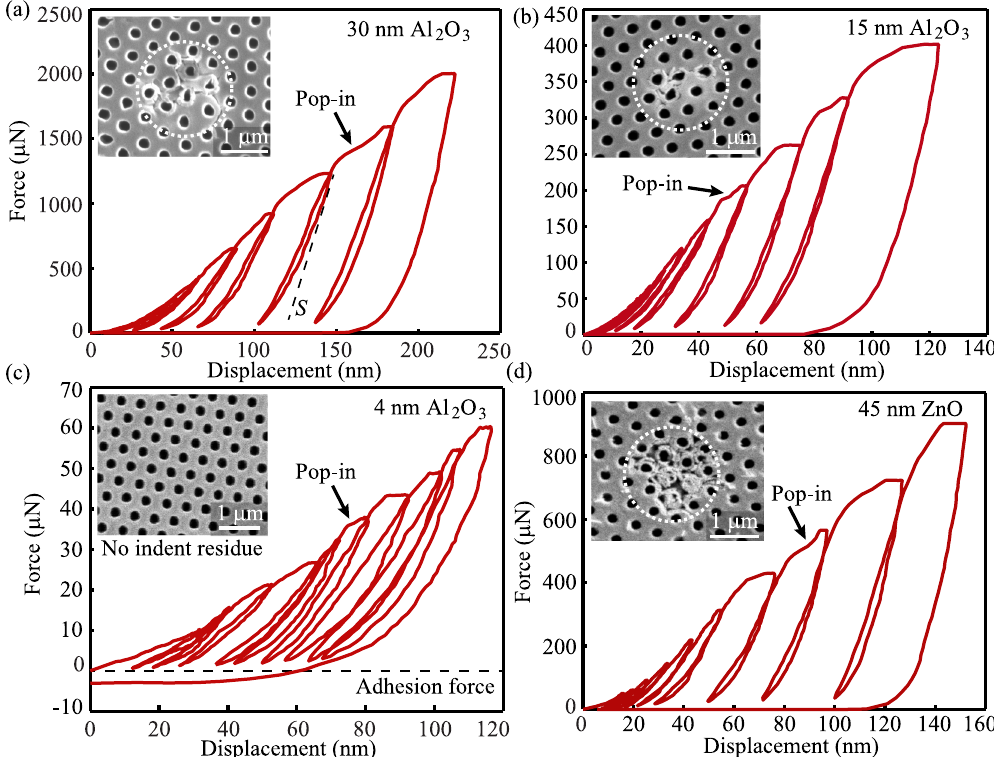
Figure 2. Mechanical testing of nanolattice using nanoindentation. ( a ) Typical cyclic load-displacement curve for 30 nm Al 2 O 3 nanolattice. ‘Pop-in’ indicates first instance of mechanical failure of nanolattice film. Inset shows post-indent SEM image with residual indentation imprint, showing brittle fracture of top planar layer. ( b) Load-displacement curve for 15 nm Al 2 O 3 nanolattice showing similar loading-unloading behavior as 30 nm Al 2 O 3 nanolattice. This is the thinnest sample tested which failed by fracture of top planar layer. ( c ) Load-displacement curve for 4 nm Al 2 O 3 nanolattice showing gradual ‘pop-in’ event. Inset shows post-indent SEM with no residual indentation imprint. Non-zero adhesion force from van der Waal’s attraction between the diamond indent and Al 2 O 3 nanolattice indicate near-complete recovery post indentation. ( d ) Load- displacement curve for 45 nm ZnO nanolattice showing ‘pop-in’ event similar to thicker Al 2 O 3 nanolattice. Inset shows post indent SEM image with brittle fracture around holes.